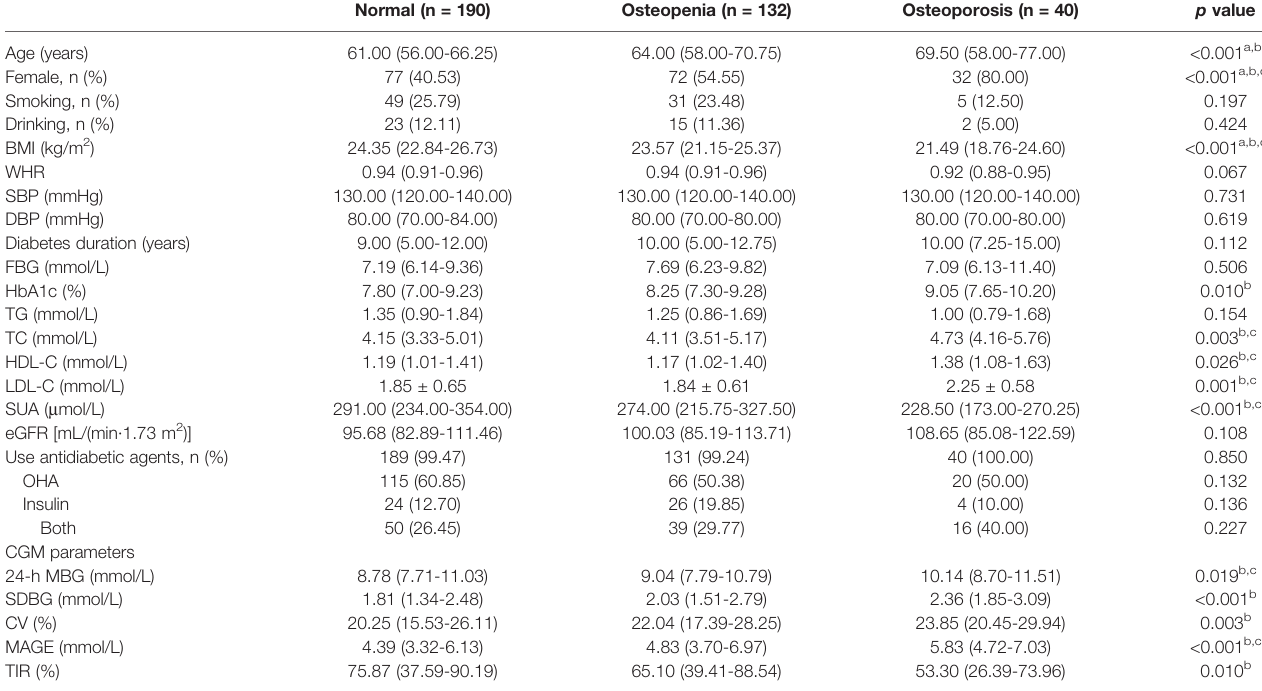
TABLE 1 | Clinical characteristics and CGM parameters of the enrolled